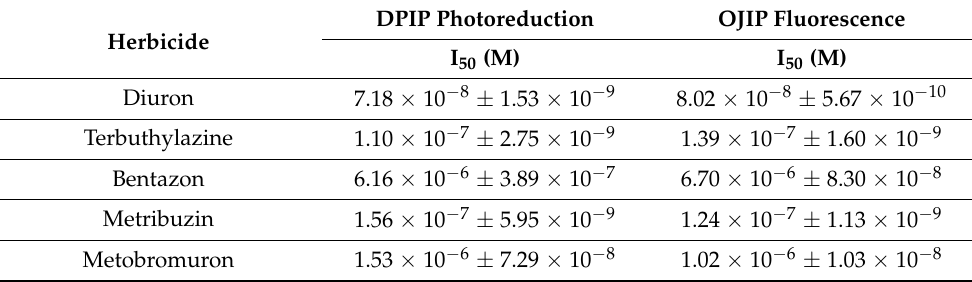
Table 2. I 50 values for different photosynthetic herbicides determined from PSII inhibition experi- ments through DPIP photoreduction (Figure 2A) and OJIP fluorescence transient (Figure 2B) assays. The I 50 values and the corresponding standard errors were computed by fitting the experimental data using the Langmuir adsorption isotherm according to